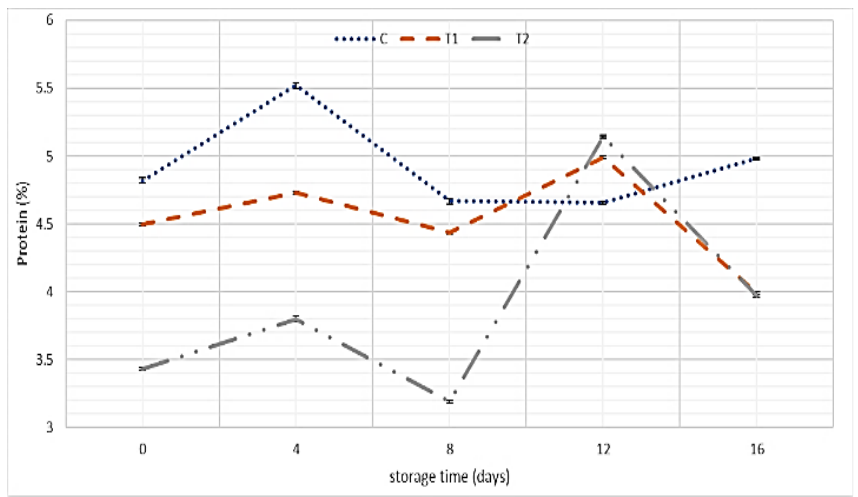
Figure 4. TP percentages of SLY samples without and with REO addition during storage up to 16 days.